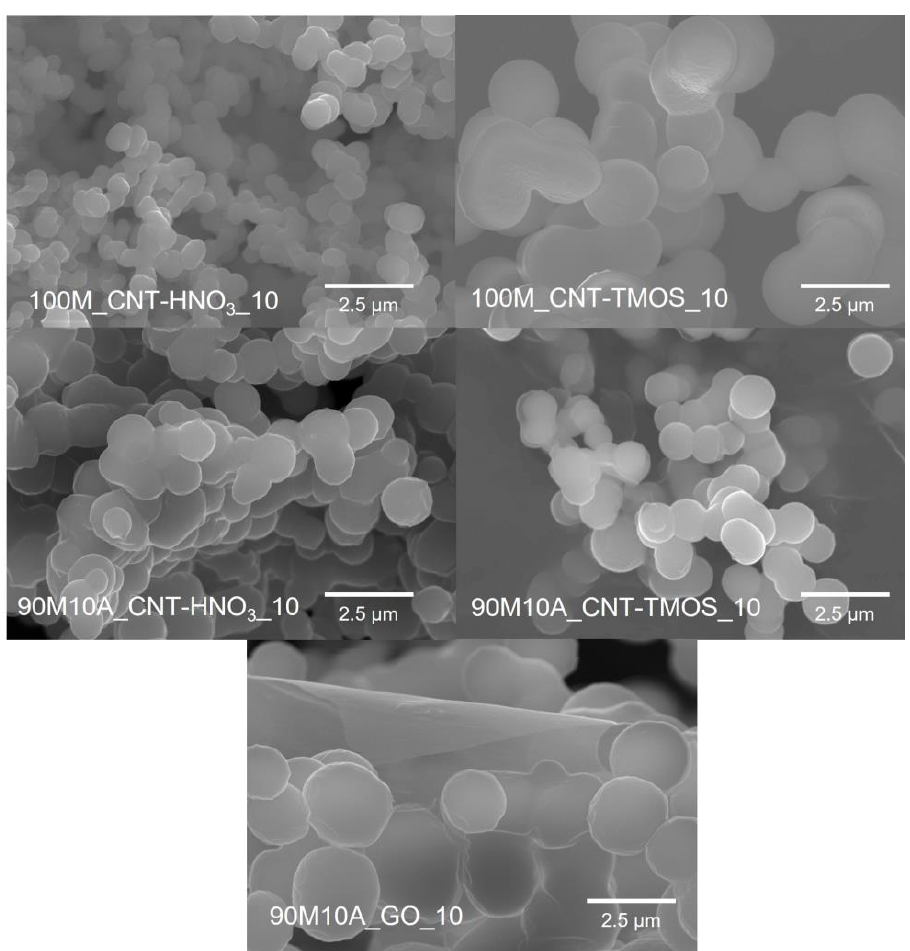
Figure 1. SEM images of the samples with 10 mg of CNTs-HNO 3 or CNT-TMOS and with 10 mg of GO obtained with 0.83 wt.% of surfactant. (Magnification — ×10.0 k).